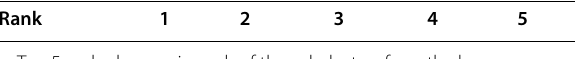
Table 4 Top 5 Ranked genes in each subcluster from a) human or b) mouse data